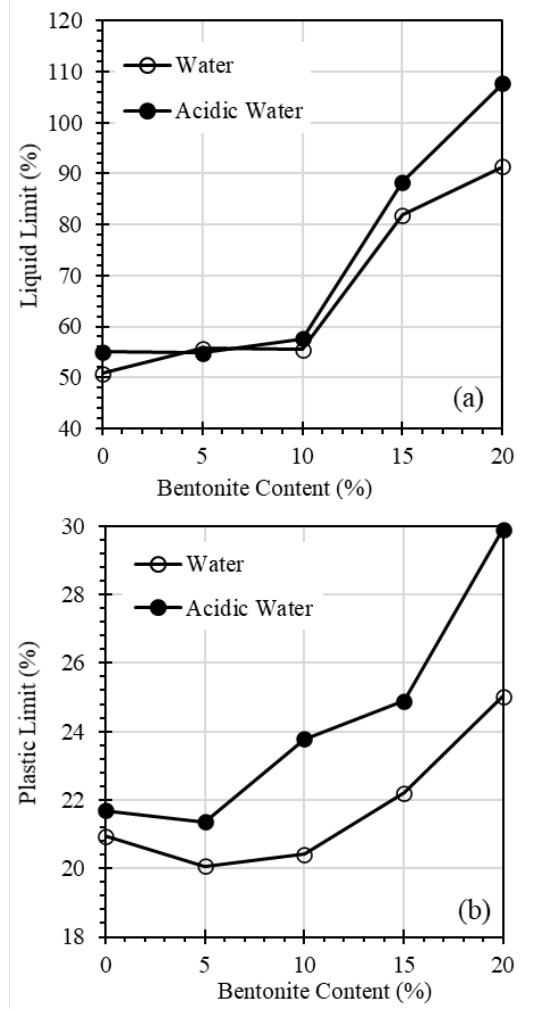
Fig. 1. Effect on acidic water on liquid limit and plastic limit of claystone‒bentonite mixtures